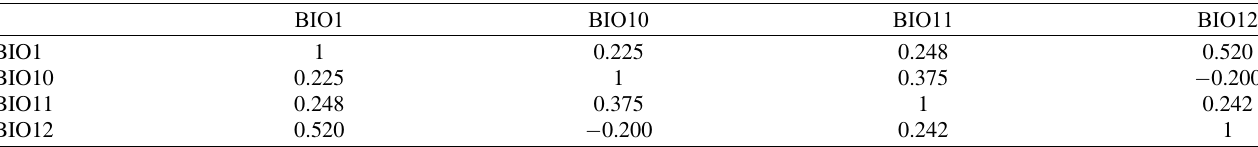
Table 3. Correlation matrix of the bioclimatic variables retained for